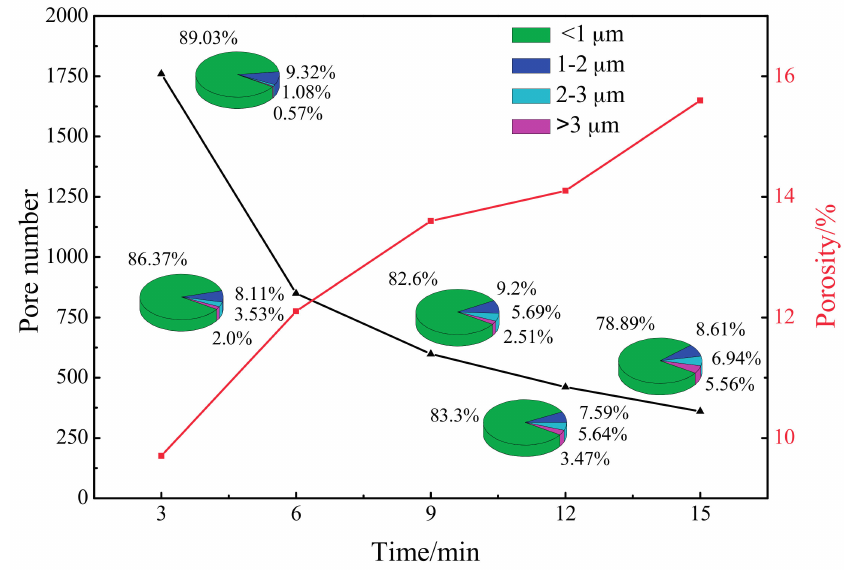
Figure 2. Statistical data of all micropores and porosity on MAO coating at different oxidation times.